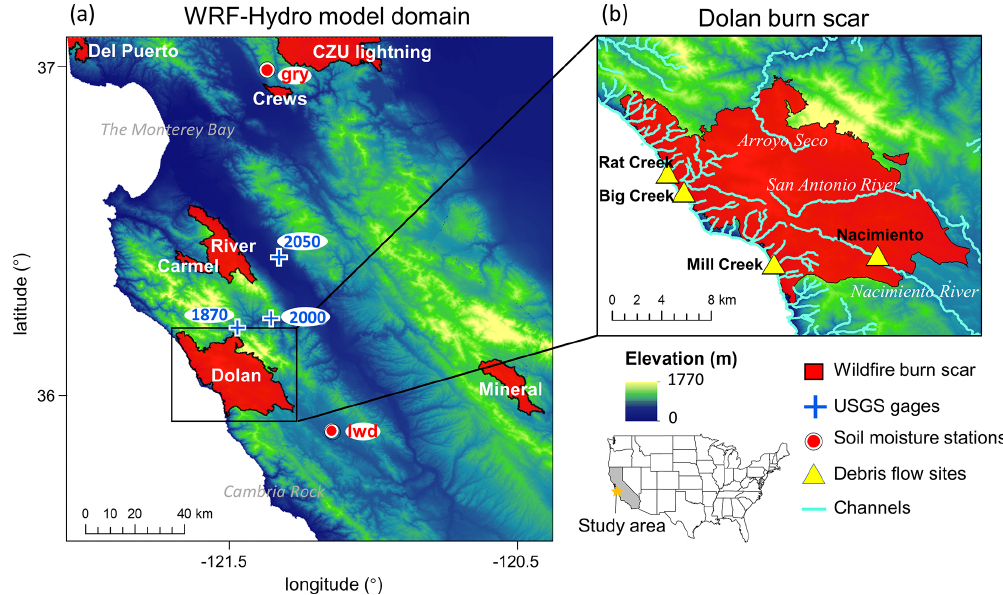
Figure 1. WRF-Hydro model domain and Dolan burn scar. (a) WRF-Hydro model domain depicting topography, 2020 wildfire season burn scars, and PSL soil moisture and USGS stream gage observing sites. The black rectangle outlines (b) the Dolan burn scar inset, in which debris flow locations and major streams are marked and labeled. The location of the study area is shown on the embedded US map with the state of California shaded in gray.